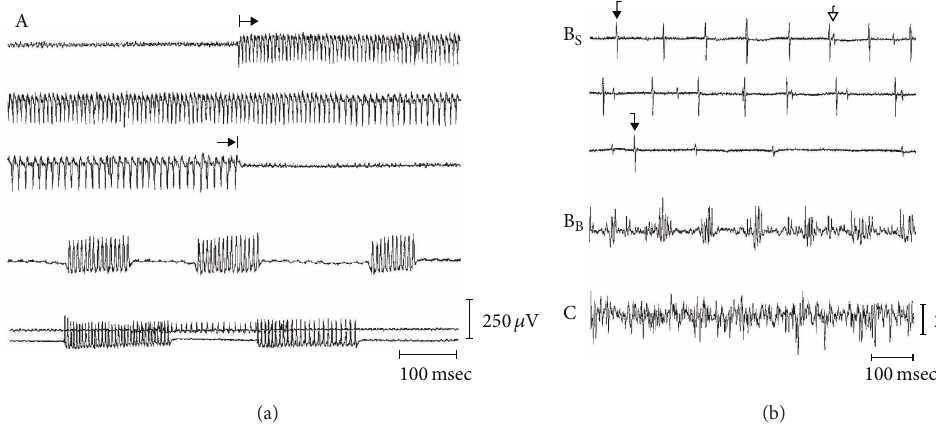
Figure 3: Electromyographic train activity. (a) Examples of A-trains of various duration and frequency. (b) Waveforms defined as B-trains with spikes (B S ), and B-trains with bursts (B B ) as predominant single components. The lowest tracing represents irregular EMG activity, called a C-train. C-trains are frequently recorded from laryngeal muscles at rest. The presence elsewhere is evidence of muscle tension and suggest insufficient sedation. Of these different forms of S-EMG activity, only A-trains are associated with neural injury. Figure from Romst¨ock et al. [29], with